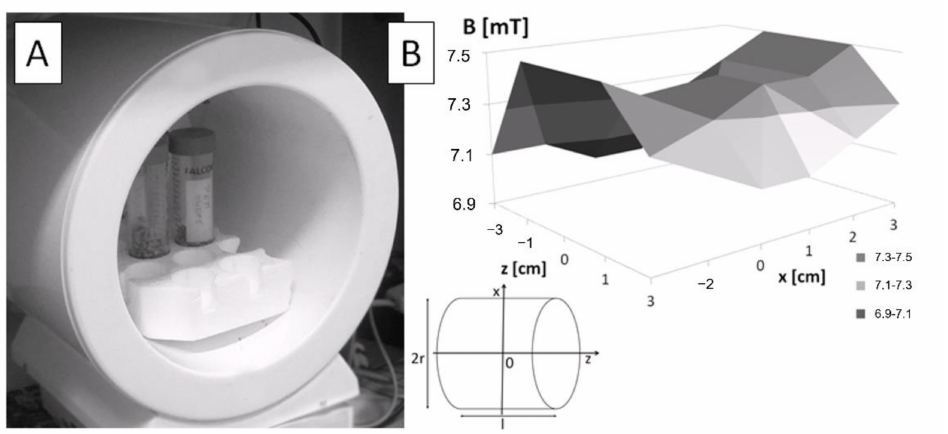
Figure 1. Exposure system. ( A ) Plant material in the coil. ( B ) The average magnetic flux density distribution inside the solenoid along the Z and X axes. Inset shows the coordinate system. 2r— diameter of the solenoid, B—magnetic flux density vector, l –coil